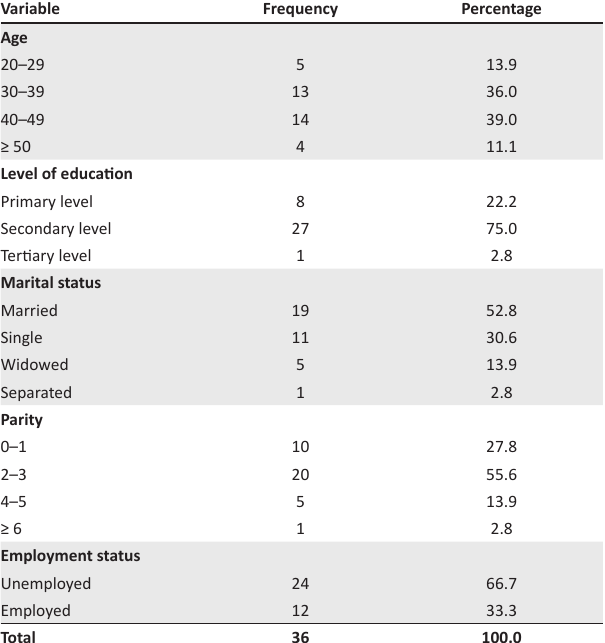
TABLE 1: Demographics of study participants ( n =